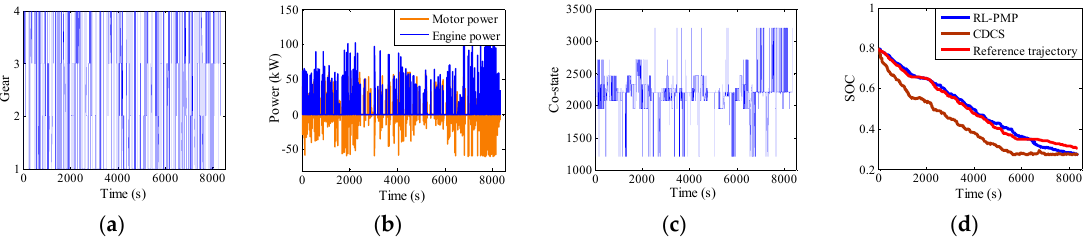
Figure 24. The HIL results of No.24. (a) denotes the gears, (b) denotes the powers of the motor and the engine, (c) denotes the co-state, and (d) denotes the SOC trajectories.